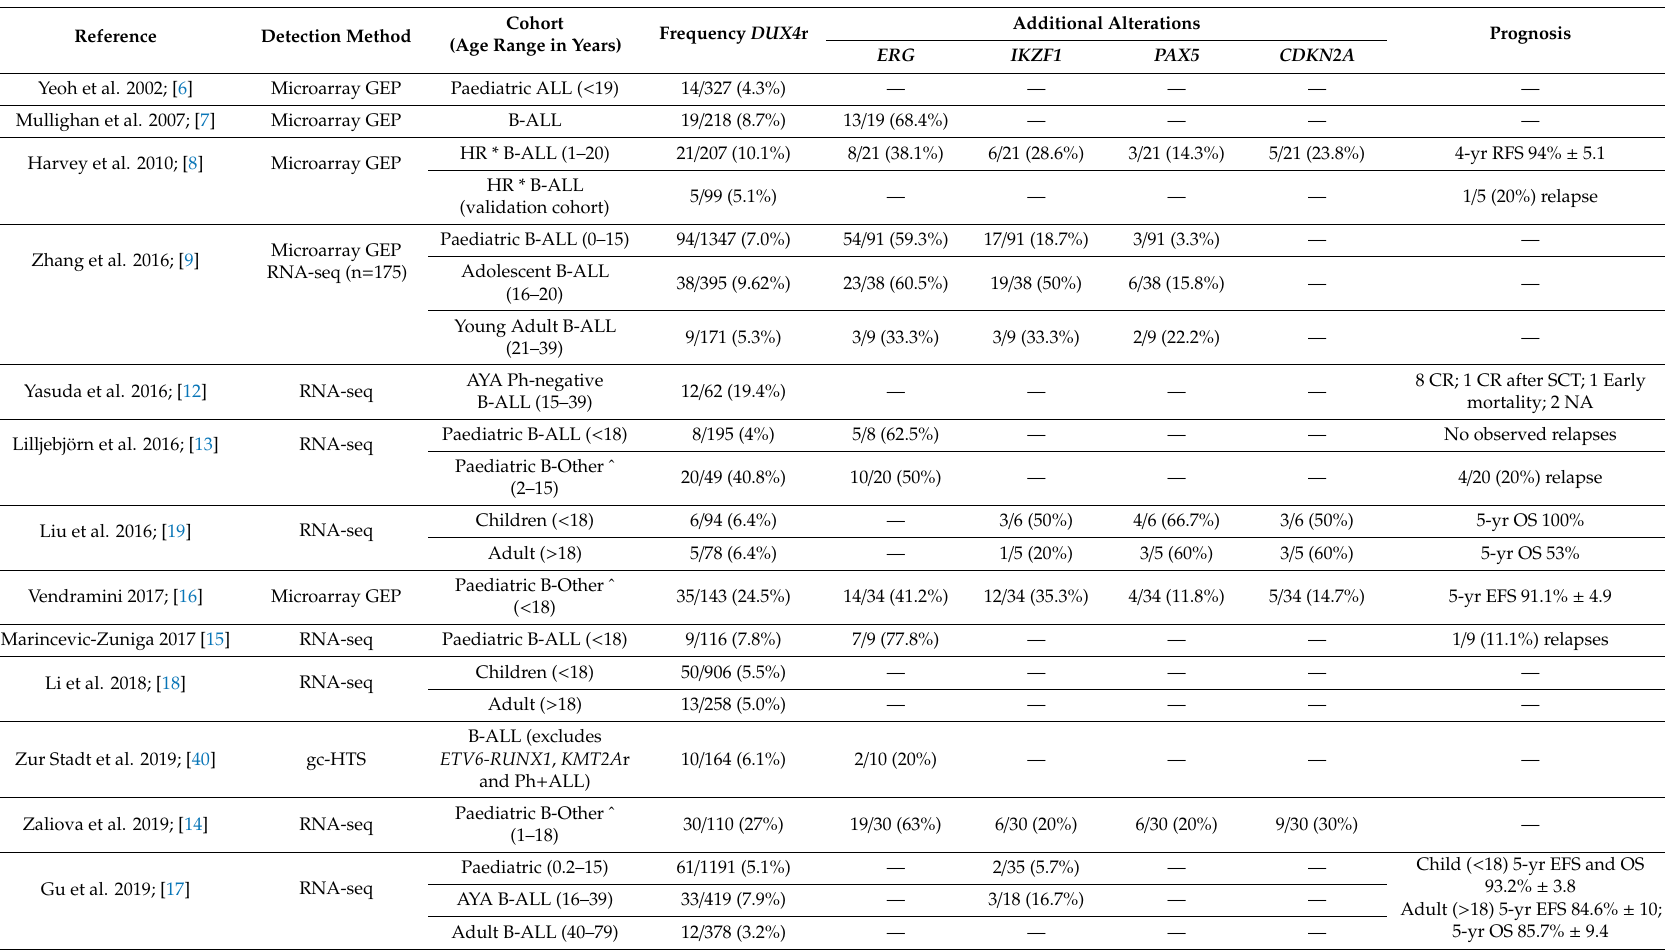
Table 1. Summary of findings from published studies identifying DUX4 r